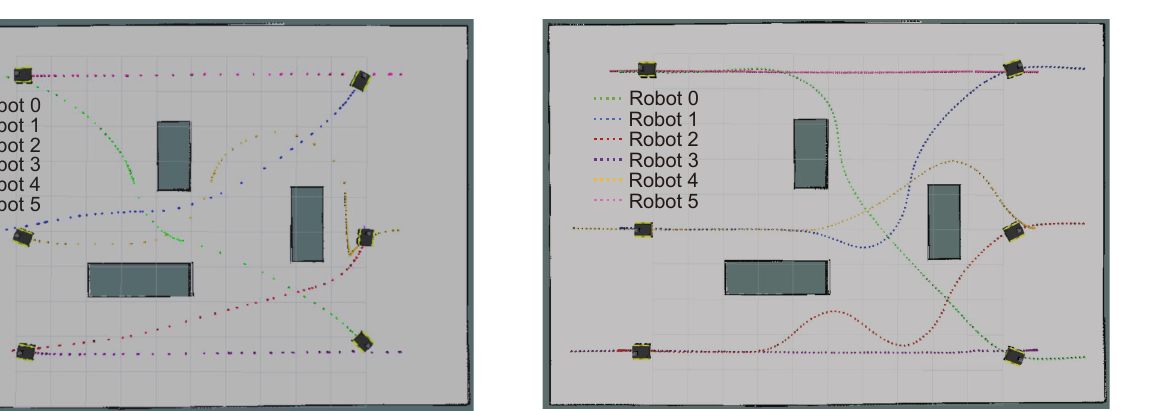
Fig. 12 Planned robot trajectories obtained using the DWA method.